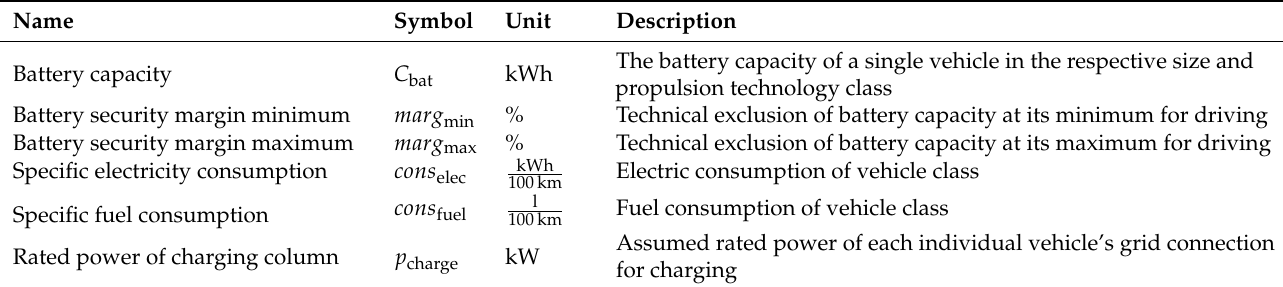
Table 2. Technical assumptions for a VencoPy